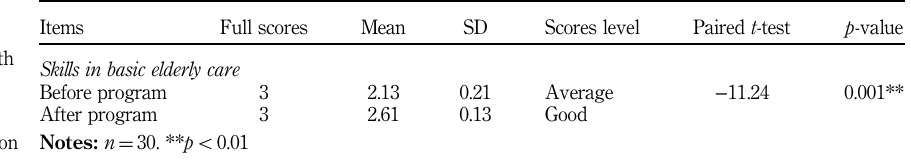
Items Full scores Table II.